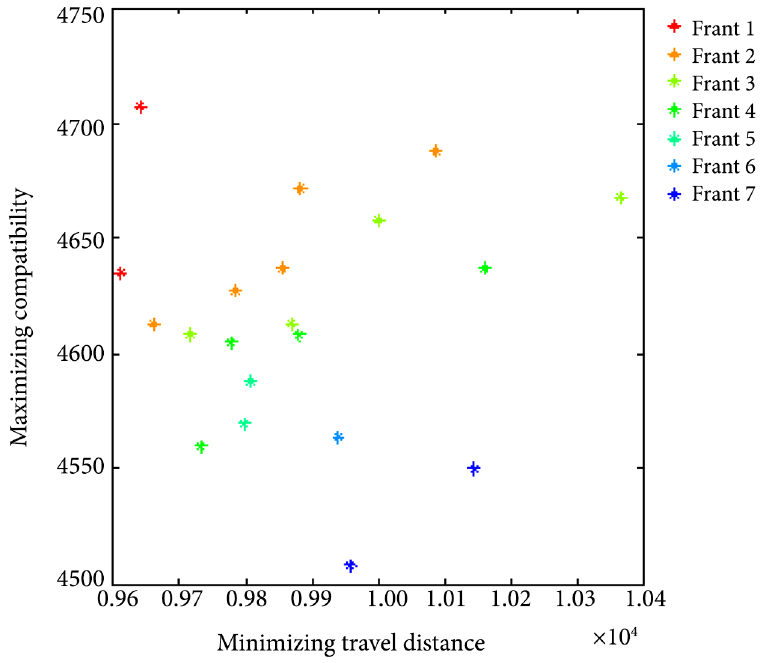
Figure 8. The first Pareto front results from the objective values of 20 primary individuals after sorting them based on their ranks and crowding distances